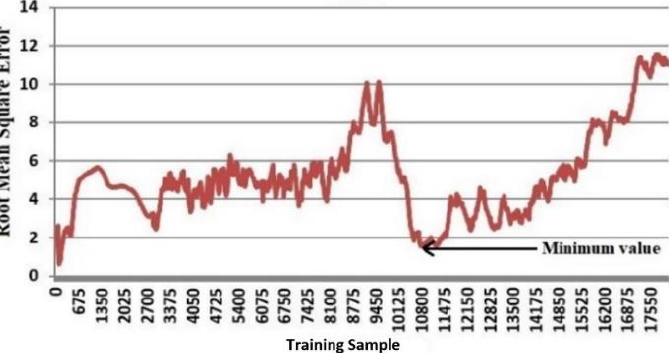
Figure 10. RMSE values for different training sample number values for short-term forecasting.